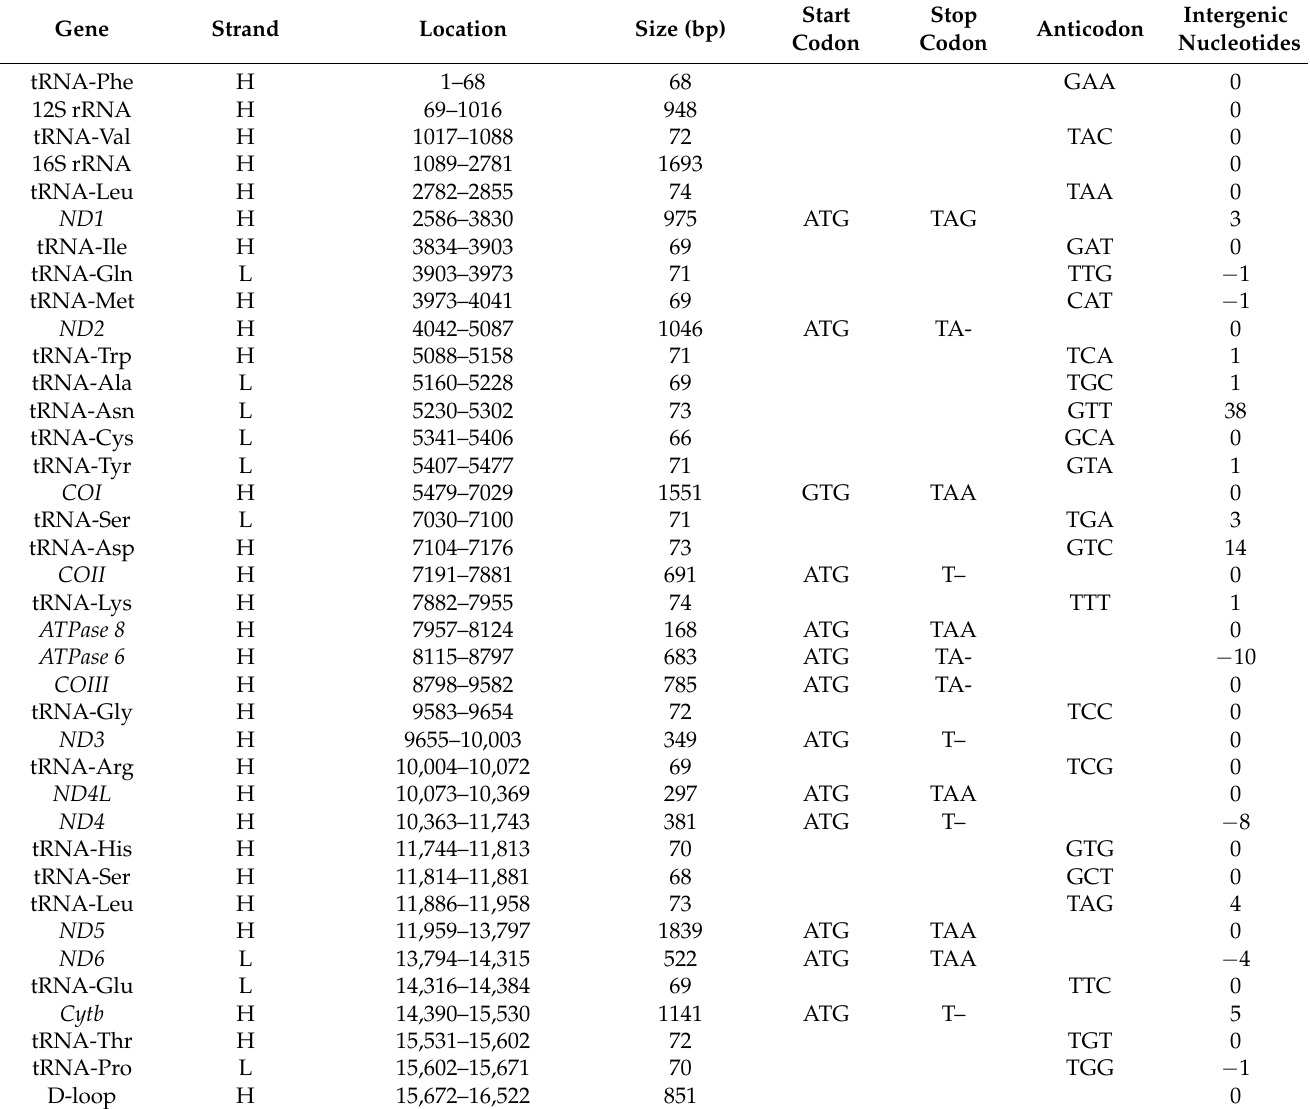
Table 2. Gene annotations of the complete mitochondrial genome of C. wui .